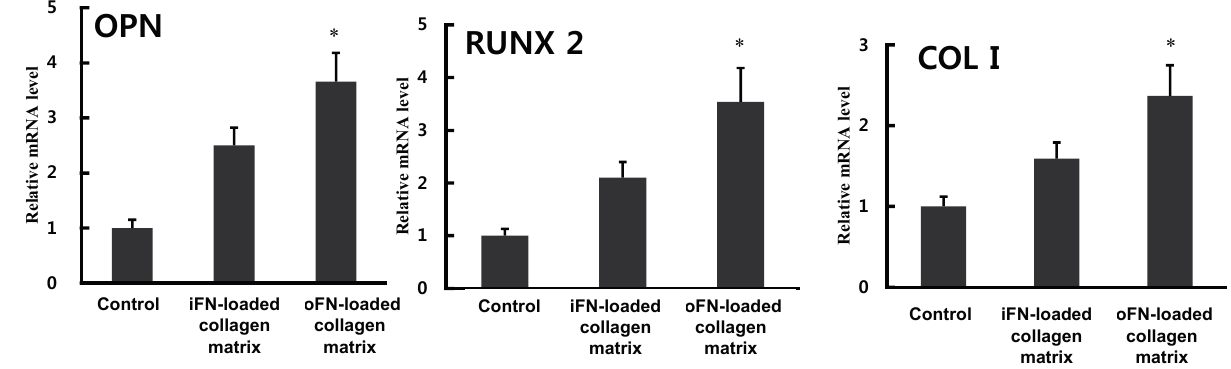
Figure 5. Osteogenic differentiation activity of osteoinductive fibronectin (oFN) matrix protein as determined by real-time PCR. MC3T3-E1 cells were cultured on collagen matrices loaded with integrin-binding fibronectin (iFN) or oFN (5 μ g·mL − 1 ) in 24-well plates. The mRNA levels of OPN , RUNX2 , and Col I were measured, and the relative mRNA level of each gene was normalized to that of GAPDH. The results are reported as mean ± standard deviation ( n = 3). * p < 0.05 compared with iFN-loaded groups or